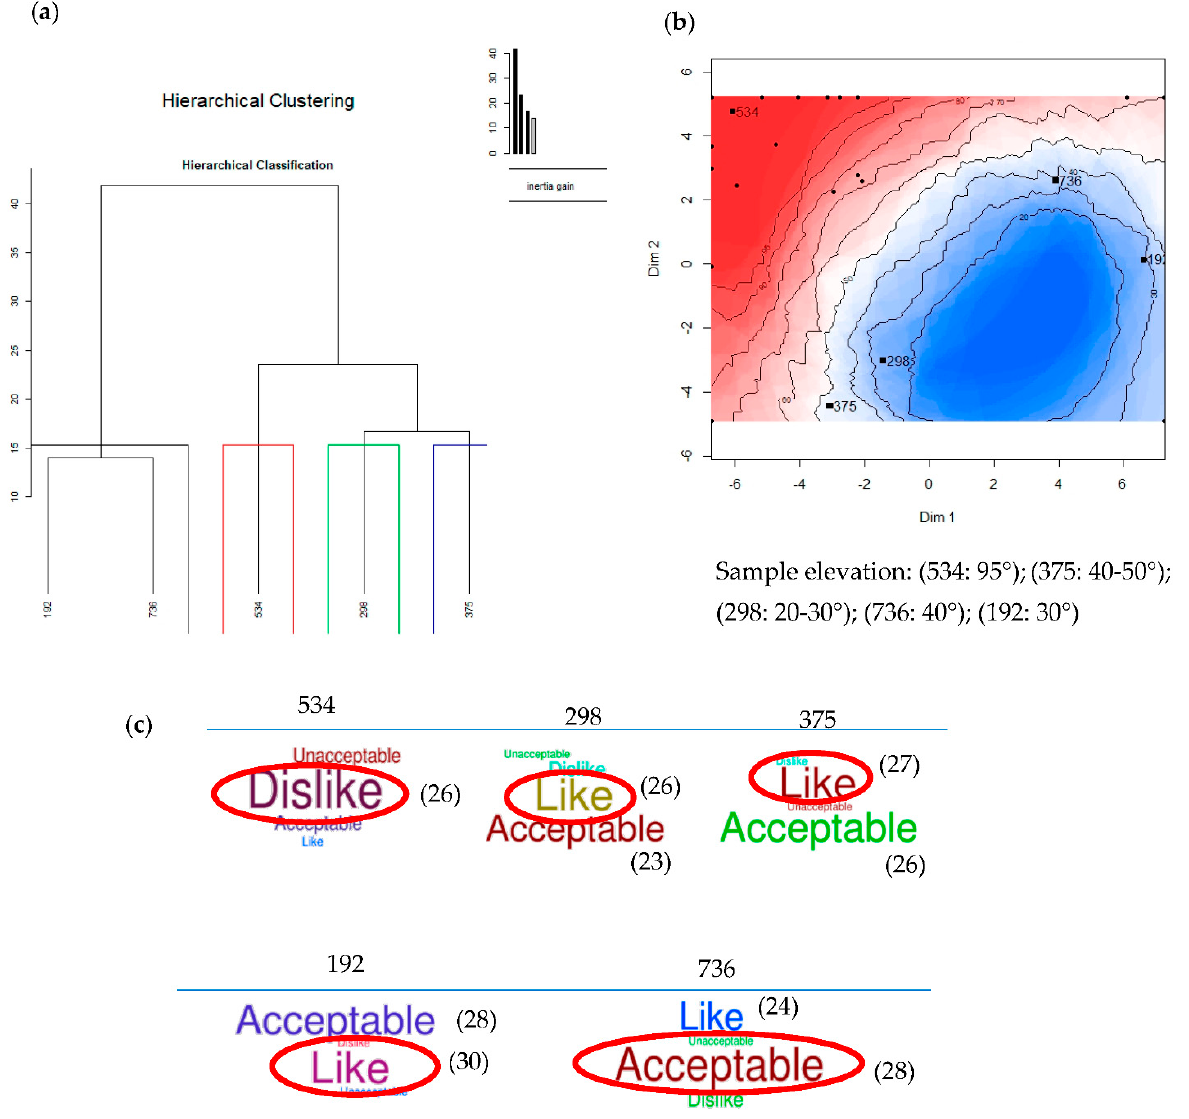
Figure 3. ( a ) Hierarchical Clustering Map; ( b ) Preference Mapping; and ( c ) Overall Acceptance (frequency panelist) of fermented and non-fermented rice bran. 534: Benchmark (Control), 192: CIF, 736: CINF, 298: IPR30F, and 375: IPR30NF.